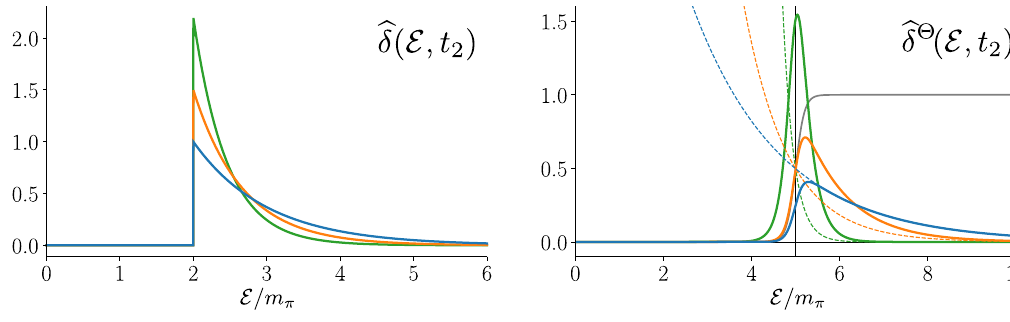
Figure 1 . Sketch of the normalized effective resolution functions, b δ ( E , t 2 ) and b δ Θ ( E , t 2 ) , defined in eqs. (2.11) and (2.12) respectively. The corresponding correlators can be written as convolution integrals of these resolution functions with the same spectral function, ρ q ( E ) , which contains the time-like information we are after. Thus, the functional forms plotted here give an indication of the energies that predominantly contribute to the correlation functions. The left panel illustrates that c q , − q ( t 2 ) is dominated by E ≈ 2 m π and that large t 2 sharpens the near-threshold resolution. By contrast, the right panel illustrates the modification involving Θ( E − 2 ω q , ∆) (also plotted here in gray) for 2 ω q = 5 m π . The three curves correspond to the same ∆ value, and the sharpening around E = 5 m π is achieved by increasing t 2 , with the dashed curves showing the corresponding factors of e − t 2 ( E− 2 ω q )